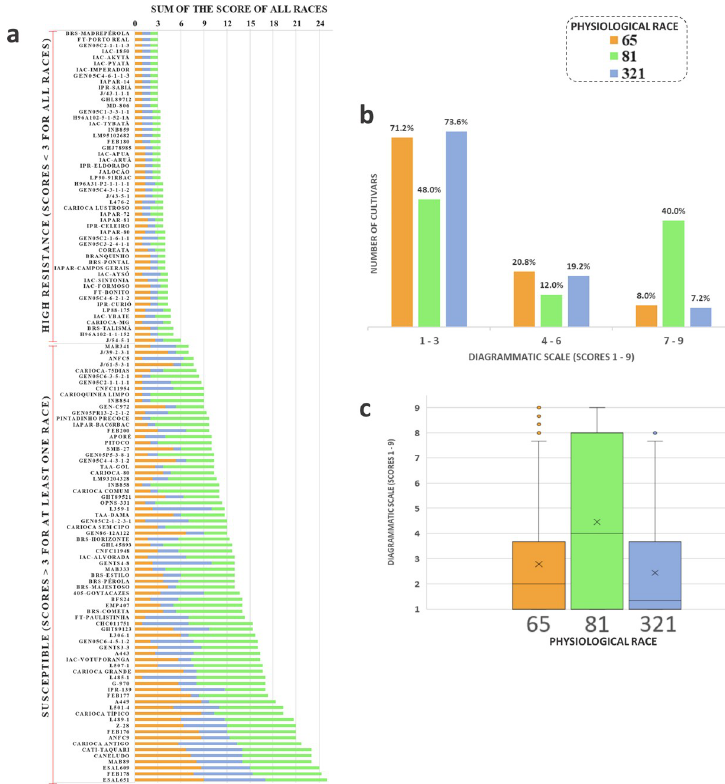
Fig 1. Phenotypic results from evaluation of carioca diversity panel (CDP) resistance to multiple races of anthracnose. (a) bar chart representing evaluation of the CDP regarding resistance to the C . lindemuthianum physiological races 65, 81, and 321. The bars represent the sum of scores of the phenotypic evaluation of each accession, with races 65, 81, and 321 being represented by colors (orange, green, and blue, respectively); (b) distribution of the number of accessions considered resistant (score � 3), moderately susceptible (score from 4 to 6), and susceptible (score � 7) for the three races evaluated; (c) boxplot for the three races